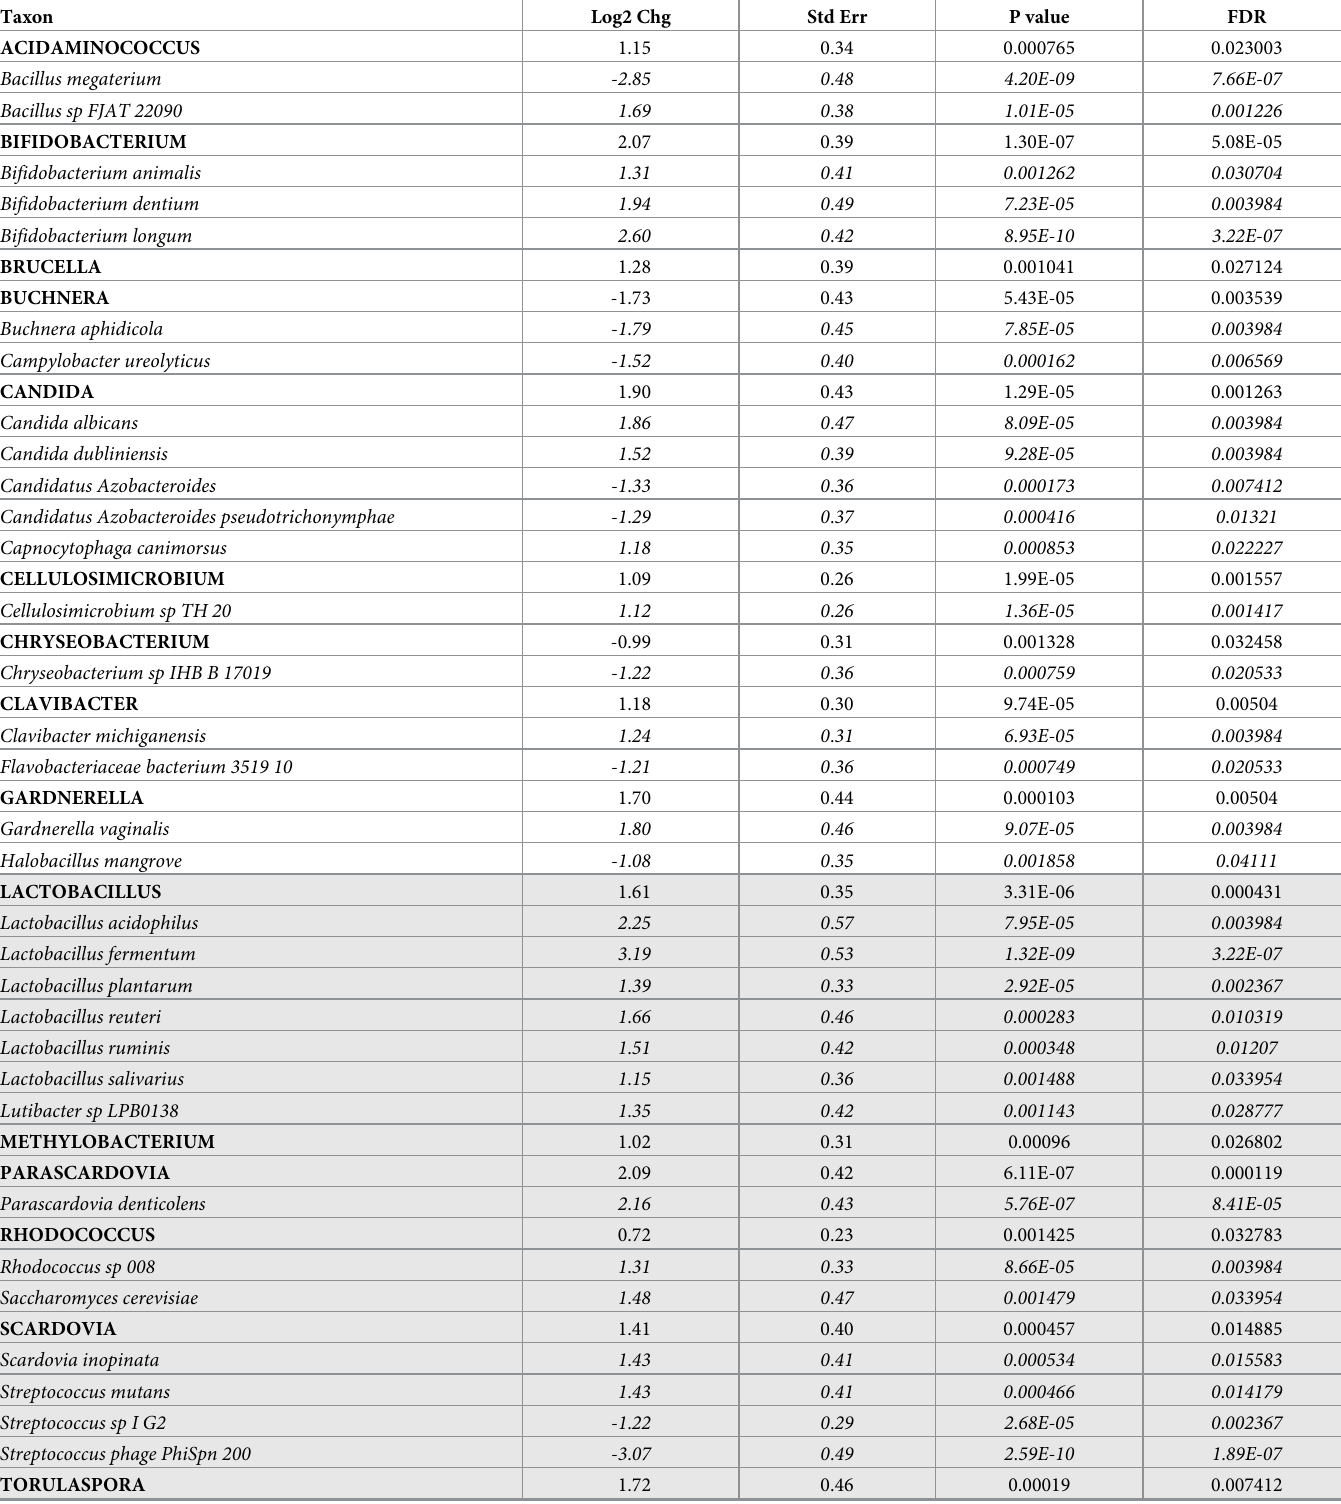
Table 4. Significantly changed microbiota in early stage PD.